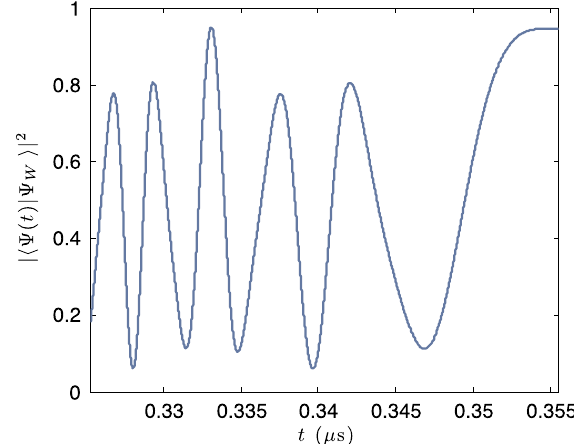
FIG. 8. Fidelity of the system state j (cid:1) ð t Þi with the target state P Q i ¼ 1 ffiffi j c i (cid:10) j 0 i j (cid:1) 3 p W j r during the final step of the r (cid:1) j j ¼ 1 in 3 = 2 (cid:3) ¼ entanglement protocol with system parameters (cid:1) max = 2 (cid:3) ¼ 30 MHz , and M ¼ 3 and damping as 120 MHz , (cid:2) max i ¼ 1 ffiffi p j 2 i þ 2 ffiffi p j 3 i þ explained in the text. The input state is j c in 6 6 e i(cid:3)= 9 1 ffiffi p j 4 i . The fidelity oscillations are due to the phases of the 6 number components evolving at different rates because of the number-dependent frequency induced by the Kerr nonlinearity at each site. Each period of the oscillations has three peaks because of the three frequency differences of the three number compo- i . The frequency of the oscillations decays to zero as nents of j c in (cid:1) is tuned to zero, and the timing (cid:2) t of the step is chosen such 7 that the oscillations cease at a fidelity peak of about 95%